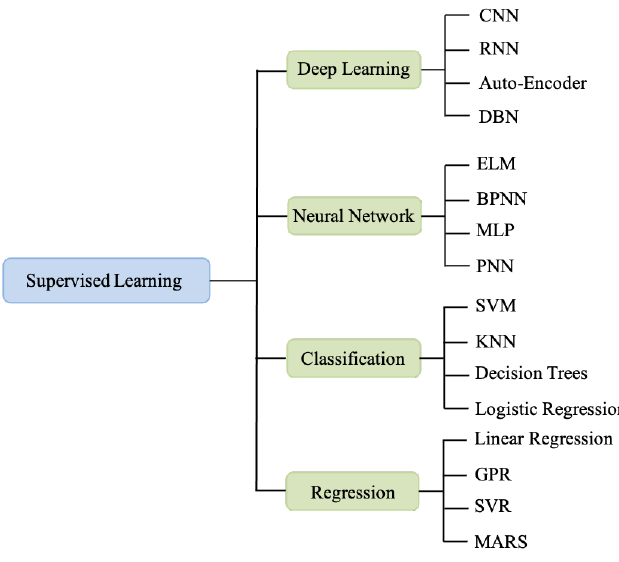
Figure 2. Supervised learning techniques in the smart